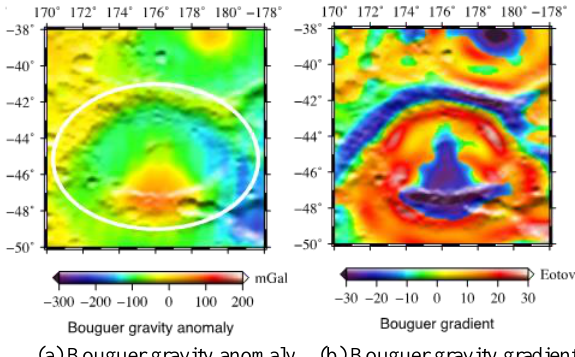
(a) Bouguer gravity anomaly (b) Bouguer gravity gradient Figure 6 Bouguer gravity anomaly and Bouguer gravity gradient map (http://pds-geosciences.wustl.edu/) 4. CE-4 LANDING SITE Centred at the landing site (177.588°E, 45.457°S), the geography, elevation and FTA maps are generated using WAC image, LOLA data, and Clementine UV-VIS data (Figure 7). Figure 7(a) indicates that there only exist smaller craters, Figure 7(b) hints a fairly flat surface, and Figure 7(c) postulates a considerably even FTA distribution. However, there exist 7(a). Moreover, the elevation also shows linear terrains orientating to the northeast direction. This again validates the strong influence of the Leibnitz and Finsen events on the